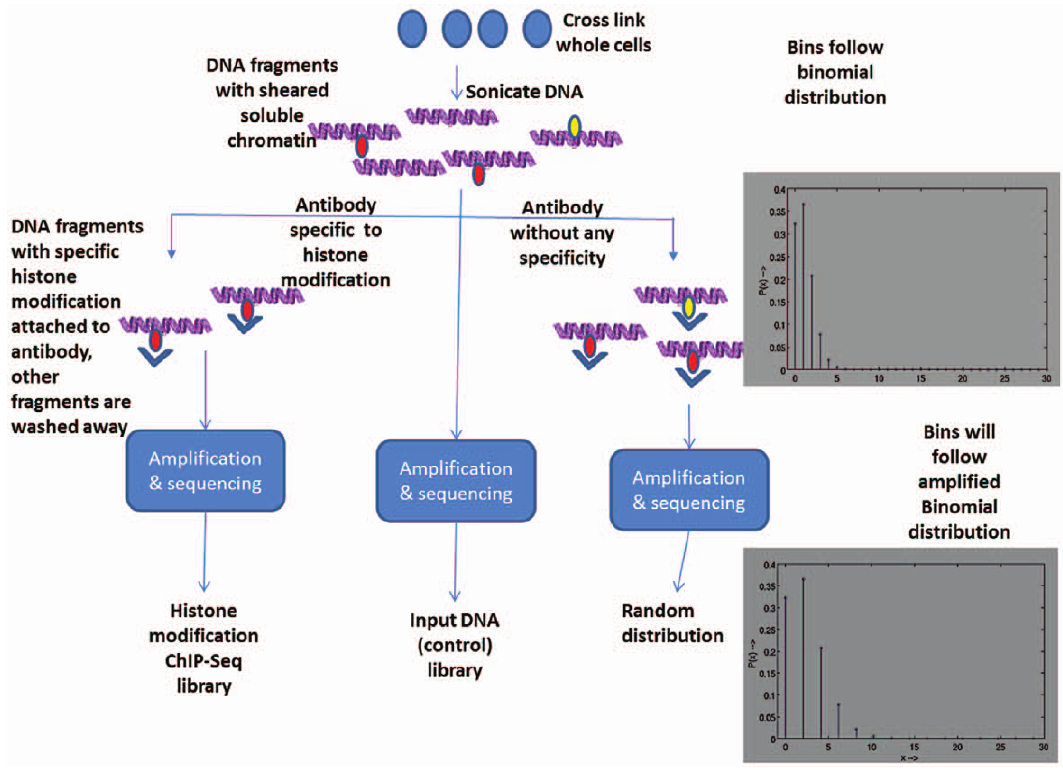
Figure 2. Overview of ChIP-seq process. We see how we can get the ChIP-seq library, input DNA control, and the random distribution (null hypothesis).